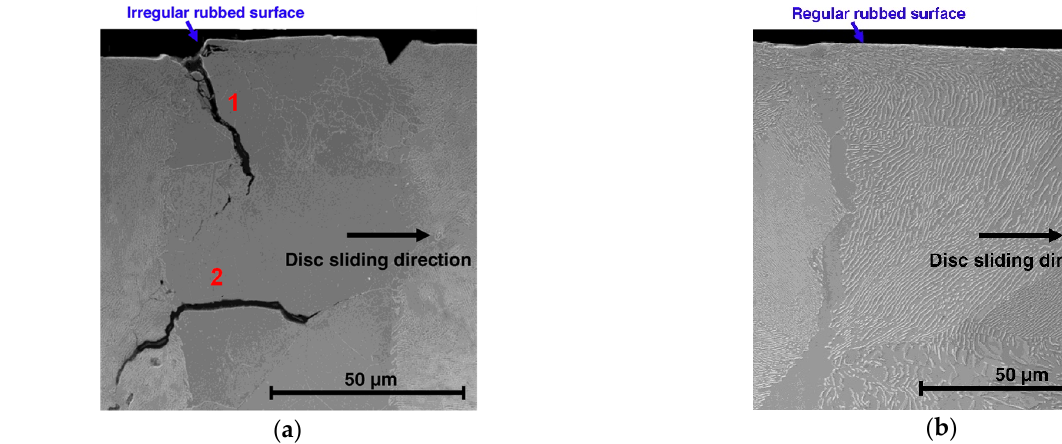
Figure 2. Images of the cross-sections of the friction ring of the brake disc obtained with a scanning electron microscope [10]: ( a ) cross-section through the area under the macroscopic hot-spot: (1) fracture perpendicular to the friction surface and (2) fracture parallel to the friction surface; ( b ) cross-section through the area free from overheating.